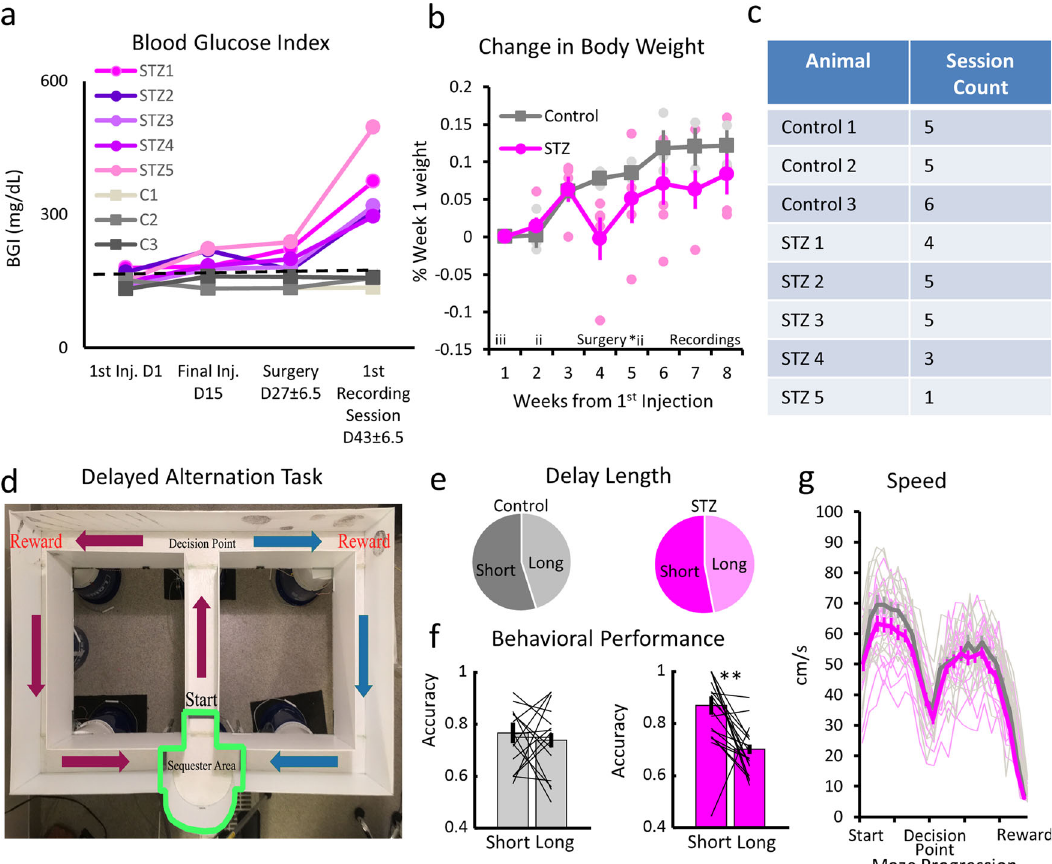
Fig. 1 Metabolic and behavioral data. a Blood glucose values from all subjects. Blood glucose index values are shown on the y -axis and the date of testing is on the x -axis. b Group body weight change. All weights were normalized to week 1 values for each subject, which was the day of the fi nal STZ or vehicle injections. i = injection day; *i = supplemental injection day. c Table of subjects and sessions. d Schematic of T-maze. e Distribution of trial delay lengths. f Accuracy by the total trial length between groups. Proportion of correct trials is on the y -axis, and total delay length is on the x -axis. g Mean running speed during trials. Running speed in centimeters per second is on the y -axis and position on the maze on the x -axis. ** p < 0.01. Error bars =